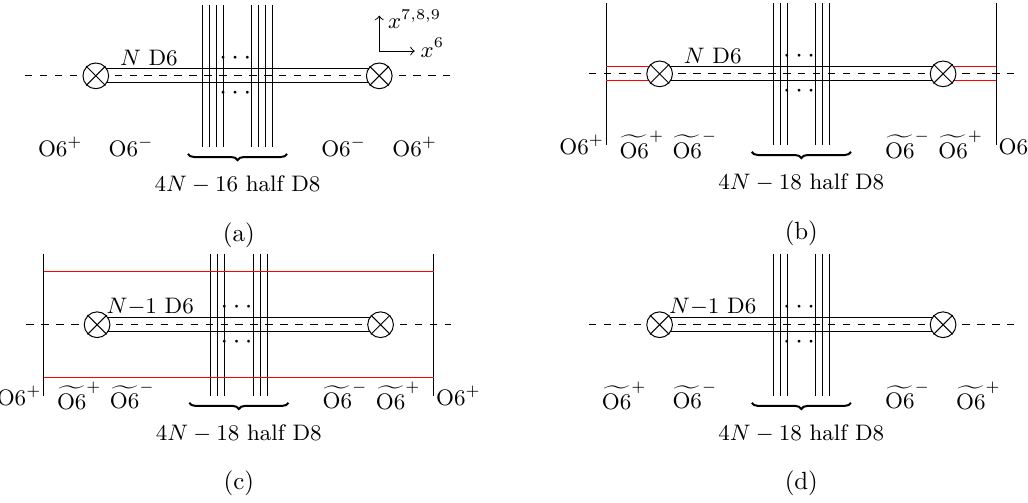
Figure 1. Higgsing of SO(2 N ) to SO(2 N − 1) . The half D6-branes are denoted by horizontal solid lines, half D8-branes are vertical solid lines, and half NS5-branes are denoted by N . The NS5-branes are drawn on the O6 orientifold which is denoted by horizontal dashed lines, and are separated along the x 6 direction. In (a), the brane configuration for SO(2 N ) is shown. Moving a half D8-brane across each of the half NS5-branes leads to brane creation as shown in (b), where the created D6 is drawn in red. In (c), a Higgs branch directions is opened up by aligning a gauge D6 with the two created D6 segments. Moving the brane along the Higgs branch off to infinity leads to the brane configuration for SO(2 N − 1) , as displayed in